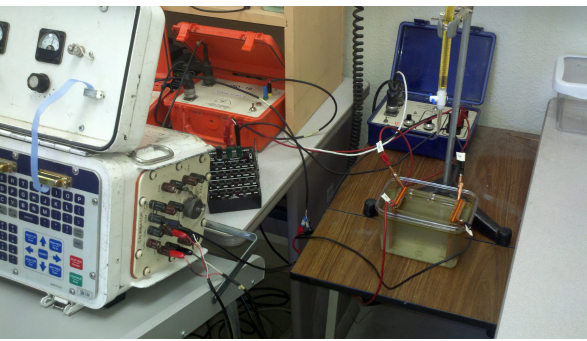
Fig. 3. The four-electrode laboratory cell used for measuring the capacitance of a multi-viscosity oil titrated into seawater. The elec- trodes are arranged in a modified Wenner array.